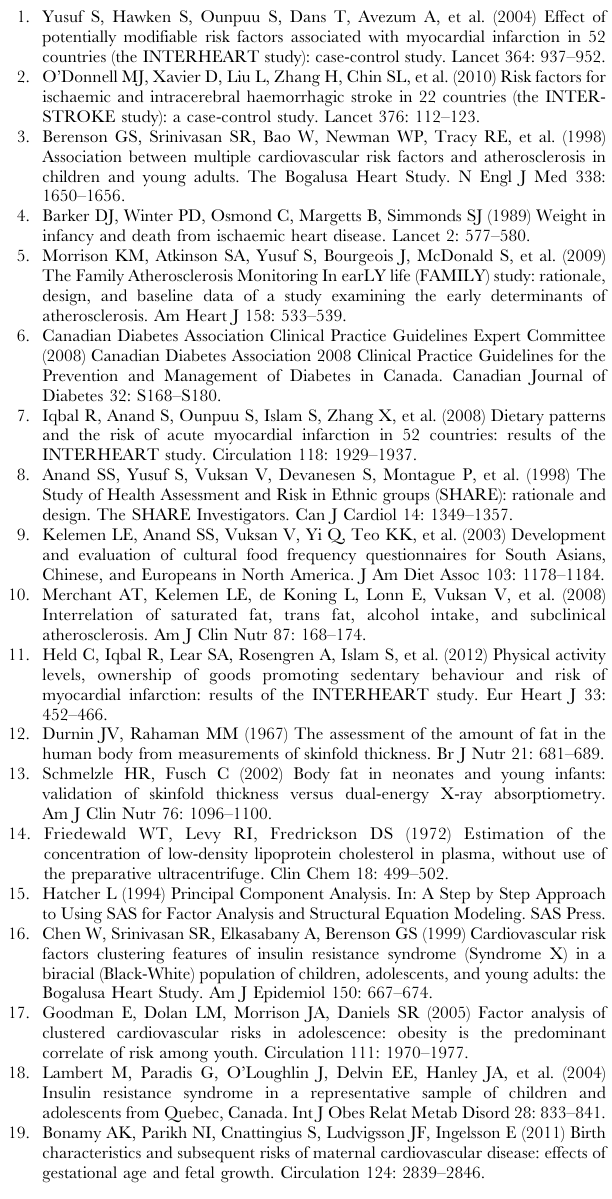
Table S1 Maternal and Newborn Demographic Characteristics and Biochemical Measures for those included and not included in the Principal Component